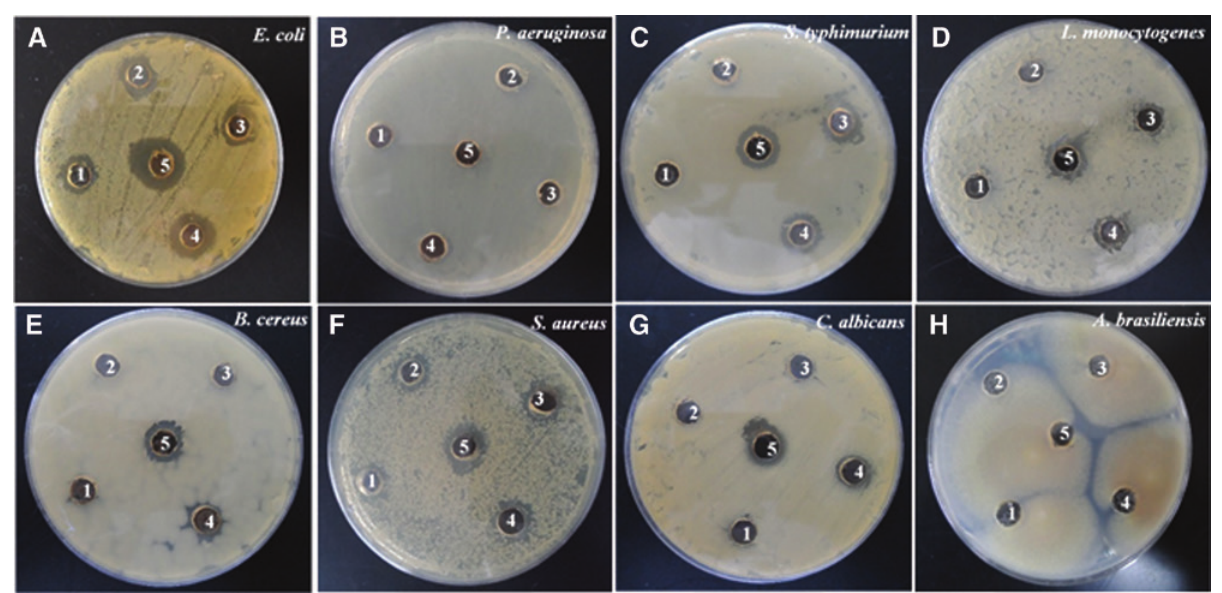
, 40 ° C, and 45 min) synthesized by DSP on (A) Escherichia coli , (B) Pseudomonas Figure 7: Antimicrobial activity of optimized AgNPs (1 mm AgNO 3 aeruginosa , (C) Salmonella typhimurium , (D) Listeria monocytogenes , (E) Bacillus cereus , (F) Staphylococcus aureus , (G) Candida albicans , and (H) Aspergillus brasiliensis . Each plate shows (1) 20 μ l of AgNPs, (2) 40 μ l AgNPs, (3) 60 μ l AgNPs, (4) 80 μ l AgNPs, and (5) 100 μ l AgNPs.